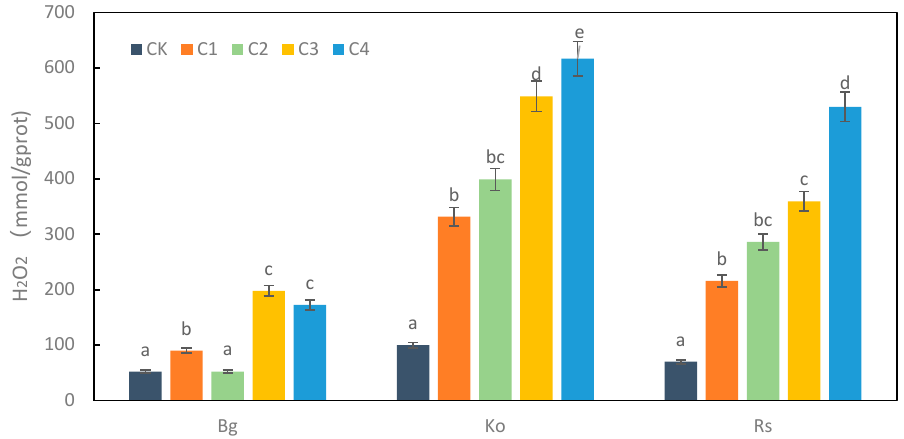
Figure 6. Morphological changes under heavy metal treatment of mangrove plants. ( A ) Bruguiera